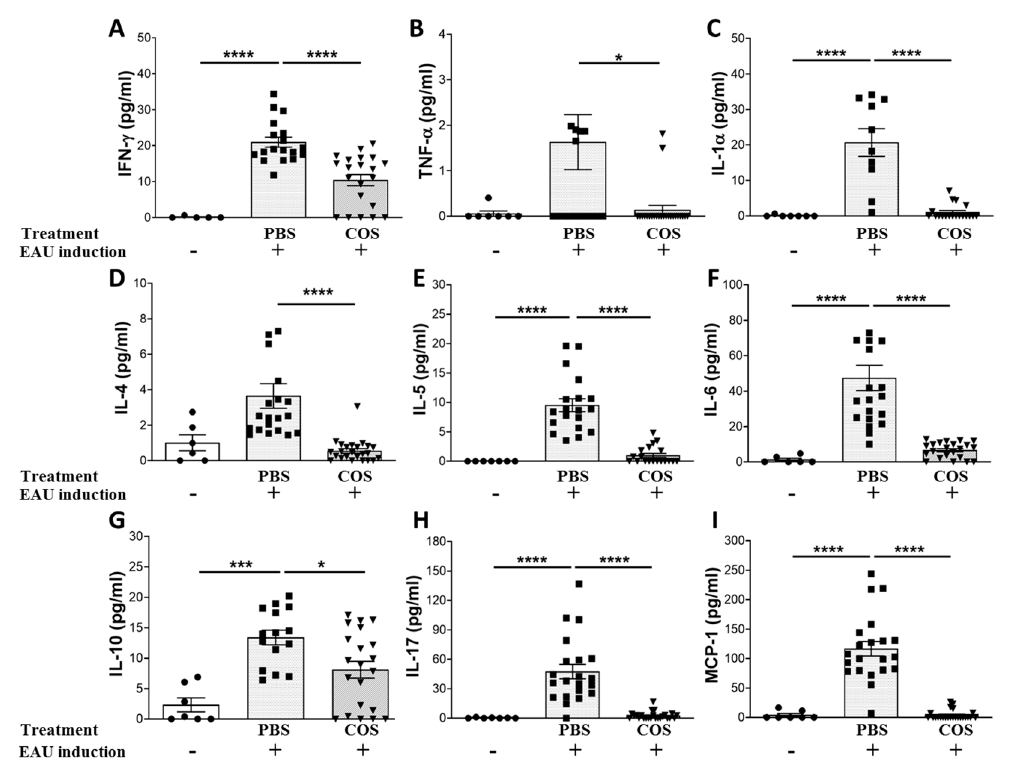
Figure 2. The influence of COS treatment on inflammatory mediators in the mouse retinas. Levels of IFN- γ ( A ), TNF- α ( B ), IL-1 α ( C ), IL-4 ( D ), IL-5 ( E ), IL-6 ( F ), IL-10 ( G ), IL-17 ( H ) and monocyte chemoattractant protein (MCP)-1 ( I ) in the retinas of mice with (+) or without (-) EAU induction and treated with PBS or COS (20 mg/kg) are shown. Data show the means ± SE values (error bars) of > 8 samples per group. * p < 0.05, *** p < 0.001, **** p < 0.0001.